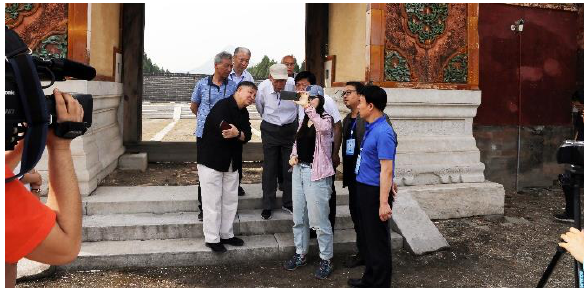
Figure 29. Experience AR at the seminar